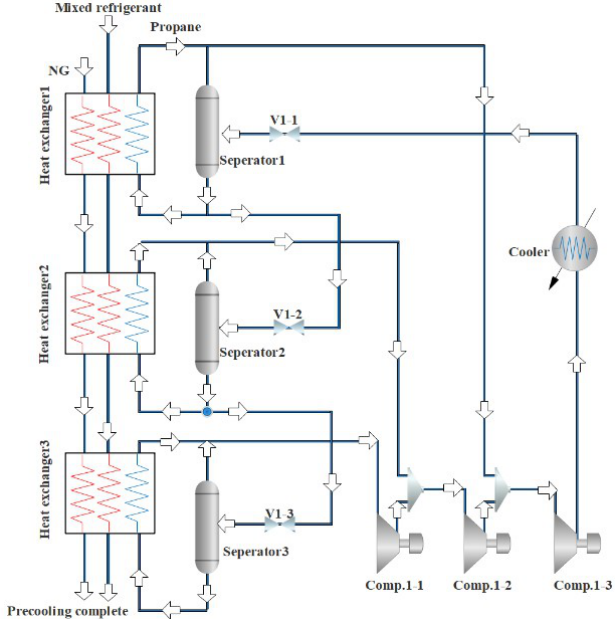
Figure 3. Flow chart of propane pre-cooling process.